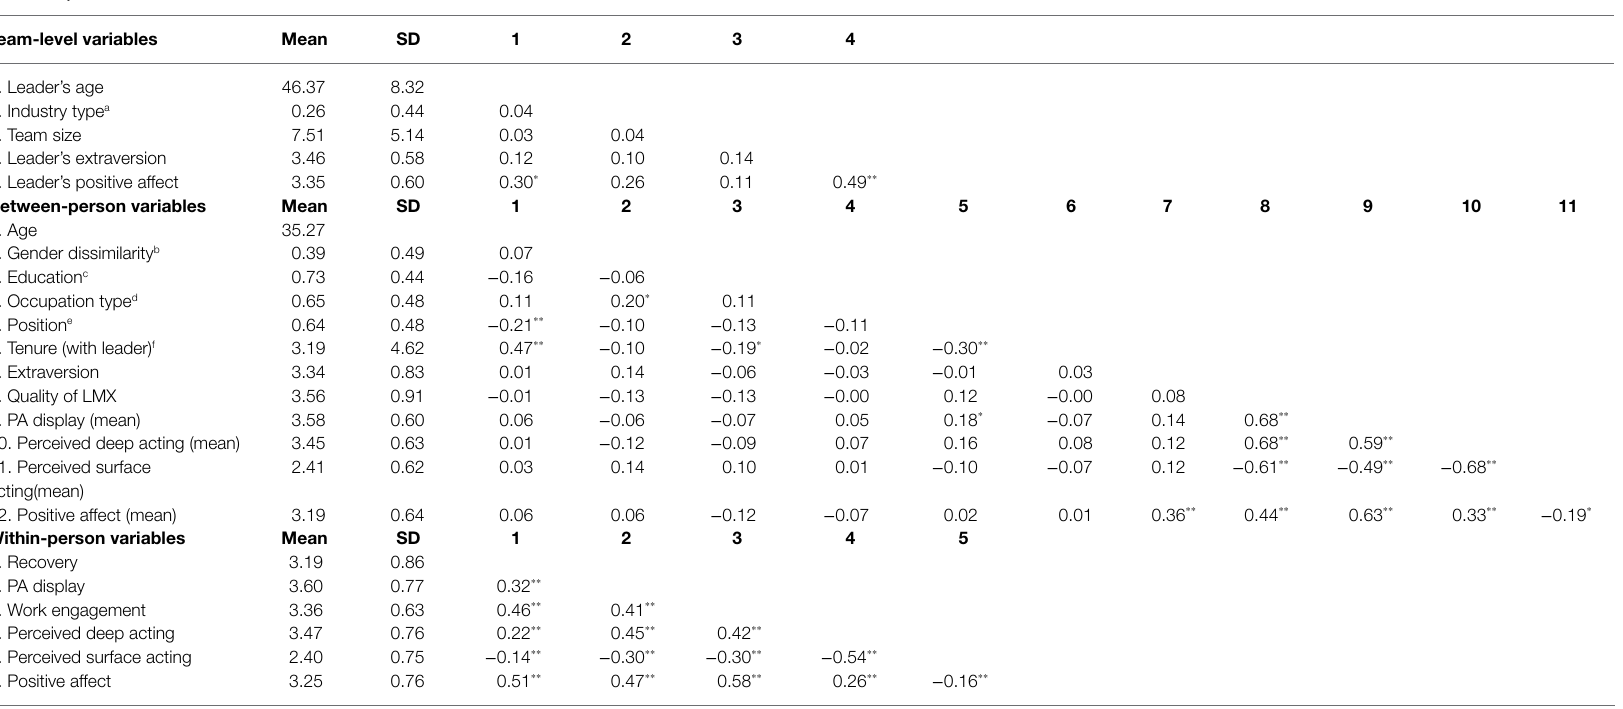
TABLE 1 | Mean, standard deviation, and correlations. Team-level